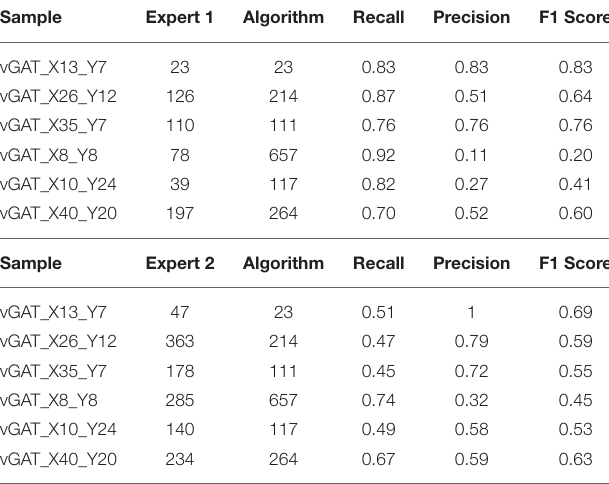
TABLE 3 | Comparison with the two experts, vGAT